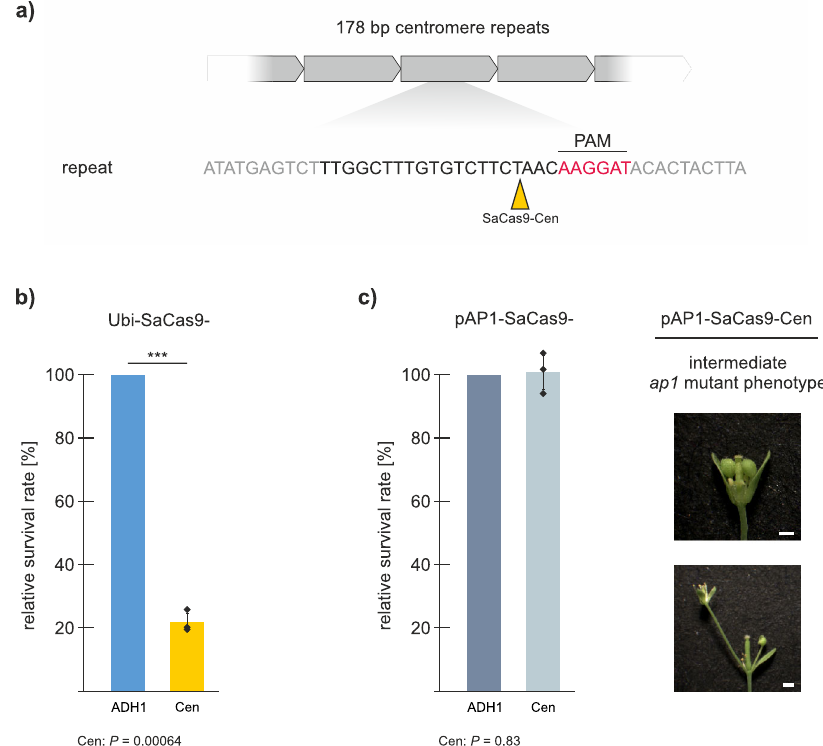
Fig. 5 Establishment of a centromere-speci fi c CRISPR-Kill system in Arabidopsis . a The core centromere is characterized by a highly repetitive cluster of functional tandem repeats. The yellow triangle represents the cleavage site for SaCas9 within the centromere repeats (SaCas9-Cen). b Transformation of Col-0 plants with Ubi-SaCas9-Cen resulted in a reduction of the survival rate of T1 plants by 80% ( n = 3 biologically independent experiments). Data are presented as normalized mean values ± SD. P = 0.00064. c Floral-speci fi c expression of SaCas9-Cen using the AP1 -promoter did not result in a reduction of the survival rate ( n = 3 biologically independent experiments). Data are presented as normalized mean values± SD. The phenotypical analysis revealed an ap1 -mutant phenotype with disturbed fl oral architecture in most cases. Bar = 1 mm. Statistical differences were calculated using the two-tailed t -test with unequal variances: *** P < 0.001. Source data are provided as a Source data fi